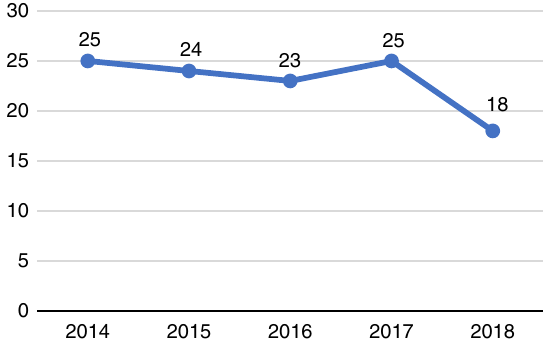
Figure 1. The distribution of the number of articles in e-learning recommendation systems from